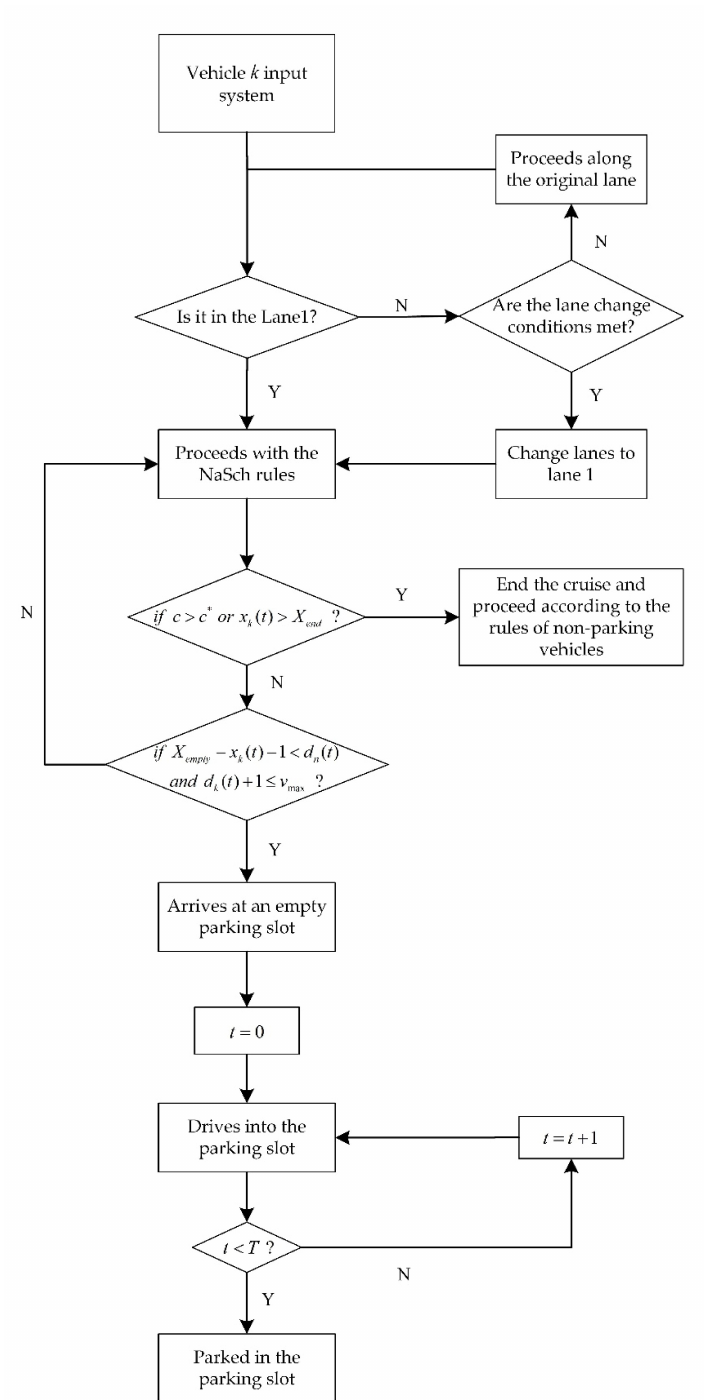
Figure 3. Parking in slots procedure for cruising for parking